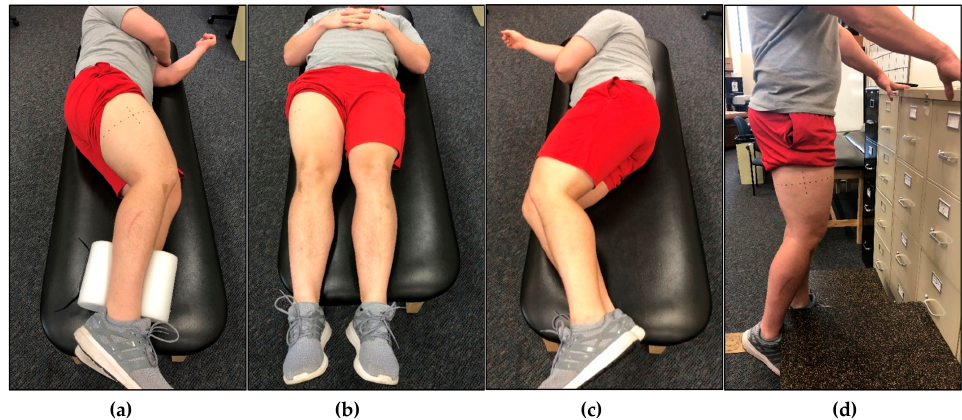
Figure 2. An example participant in different rest positions prior to ultrasound analysis of the vastus lateralis (VL) muscle. ( a ) Participant laying in the non-dominant lateral recumbent (NDLR) position with the dominant limb exposed. This was the position that all ultrasound images were captured in (except for standing), however, the rest position utilized beforehand differed. The participant utilized this rest position for immediately post (IP) analysis and rest for 15 min in the NDLR position. ( b ) Participant laying in the supine (SUP) position. After 15 min in this position, the participant was instructed to flip over to the NDLR position, and ultrasound images were captured immediately following. ( c ) Participant laying in the dominant lateral recumbent (DLR) position with the dominant leg compressed. After 15 min in this position, the participant was instructed to flip over to the NDLR position, and ultrasound images were captured immediately following. ( d ) Participant in the standing (ST) position. The ultrasound images were captured while the participant remained standing. Participants were instructed to bear weight on the non-dominant leg while resting the dominant leg against a platform to allow for a bend in the knee. Participants were instructed to stand for 15 min in between each